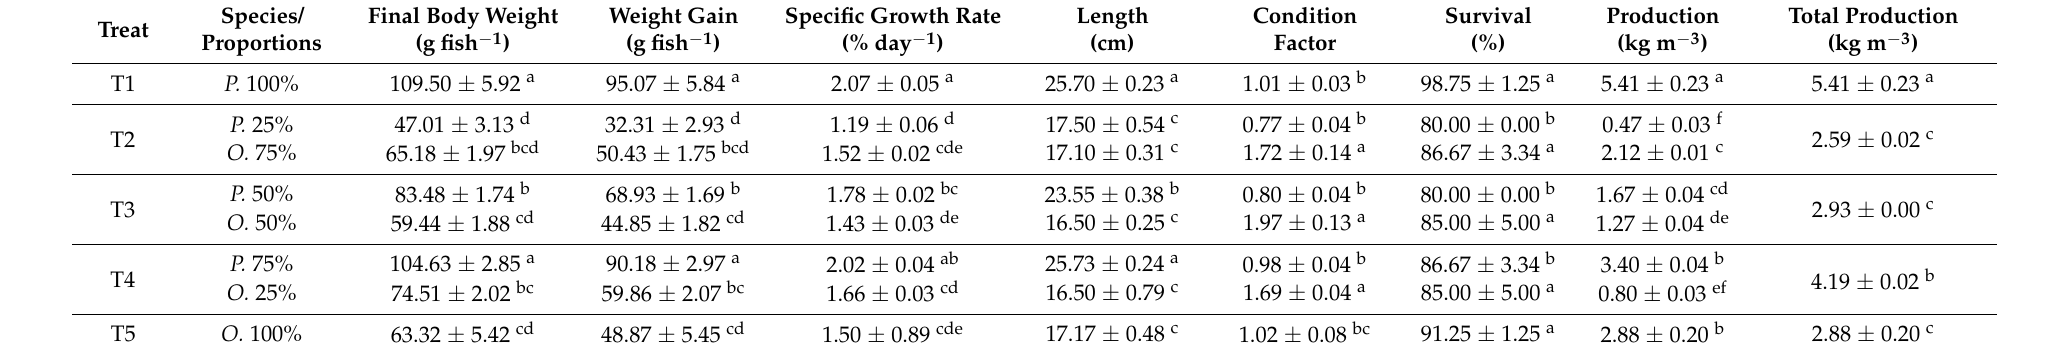
Table 2. Growth performance and production of juvenile striped catfish, Pangasianodon hypophthalmus (P.), and Nile tilapia, Oreochromis niloticus (O.), reared in monoculture and polyculture proportions for 14 weeks ( n = 3; means ±